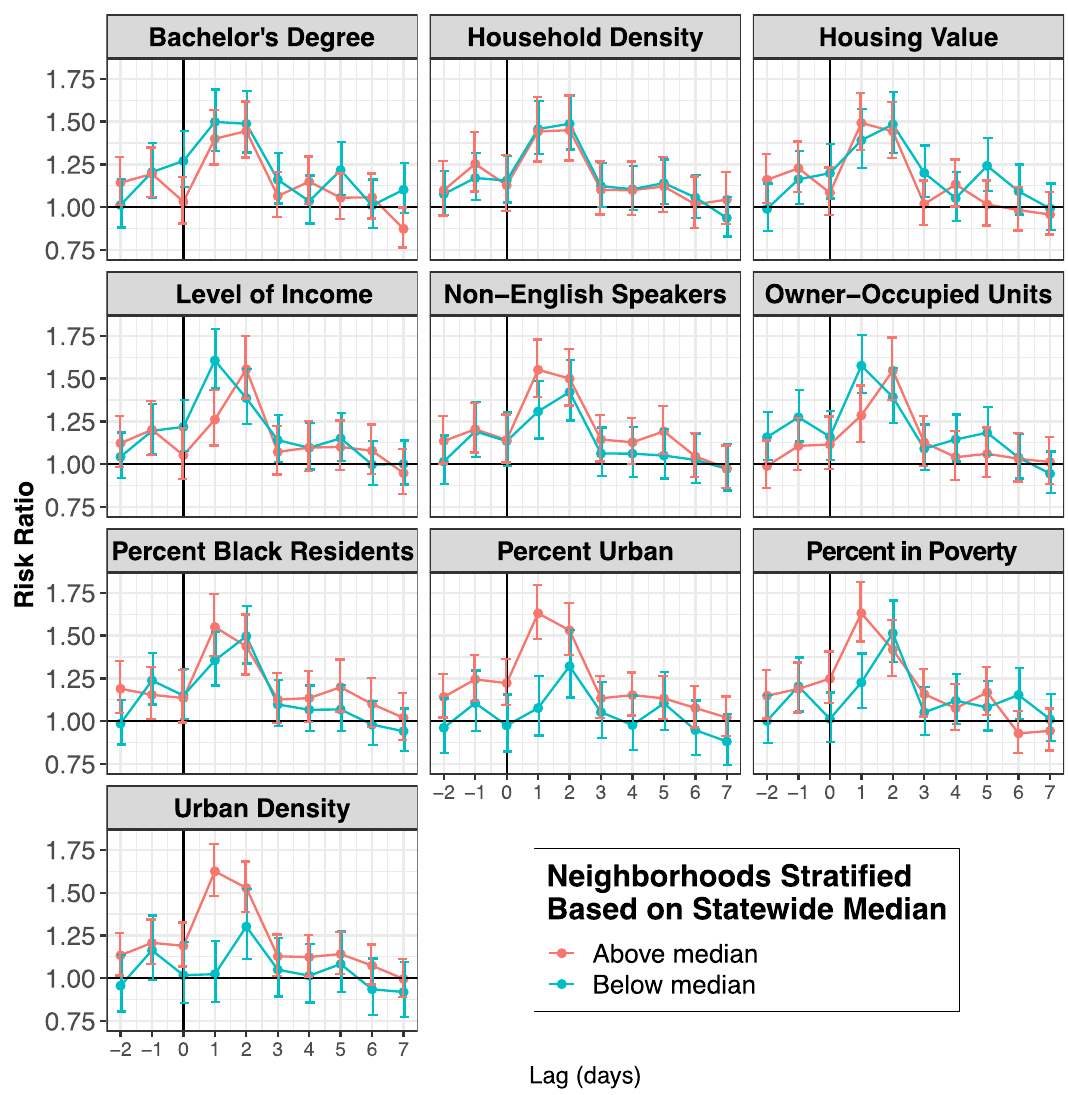
Fig. 7 | Association between tropical cyclone exposure and RD hospitalization riskin Florida ZCTAs ( n =796) from1999 to2016,from2 days before to 7 days after a storm day, strati fi ed by neighborhood-level characteristics (above